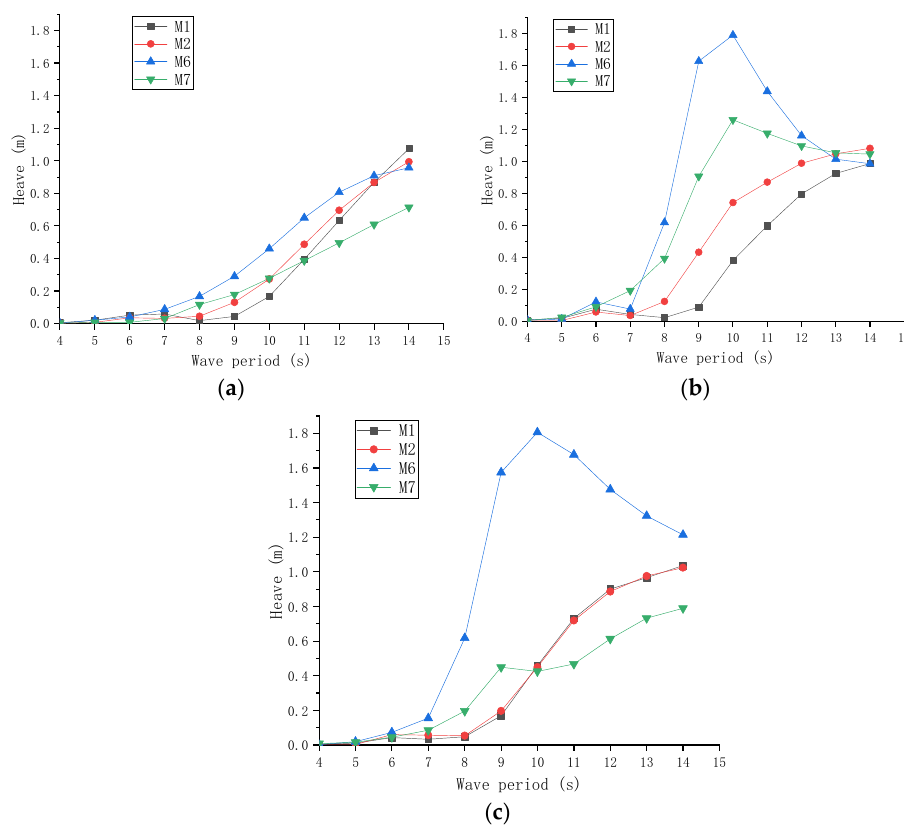
Figure 10. Heave of three expansion scheme: ( a ) scheme A; ( b ) scheme B; and ( c ) scheme C.